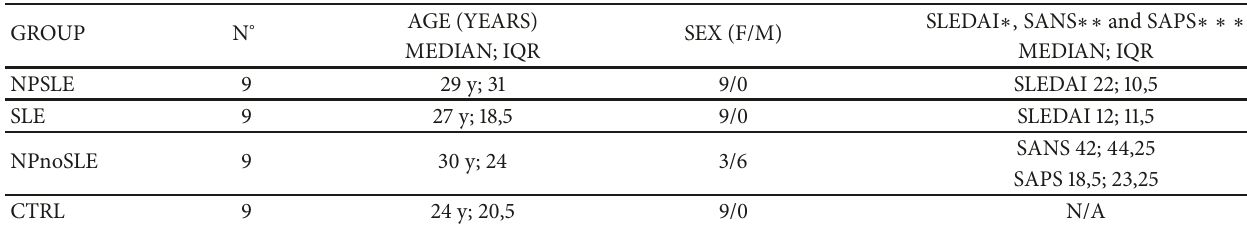
Table 1: Study groups and clinical characteristicsof the patients. The study groups were the following: NPSLE (Neuropsychiatric Systemic Lupus Erythematosus), SLE (Systemic Lupus Erythematosus), NPnoSLE (Neuropsychiatric syndromes not associated with SLE), and CTRL (healthy controls). The characteristics compared among the groups were the median and IQR of the age (in years), sex (female or male), and the median and IQR of the SLEDAI, SANS, and SAPS scales. SLEDAI ∗ = Systemic Lupus Erythematosus Disease Activity Index; SANS ∗∗ = Scale for the Assessment of Negative Symptoms; SAPS ∗ ∗ ∗ = Scale for the Assessment of Positive Symptoms.